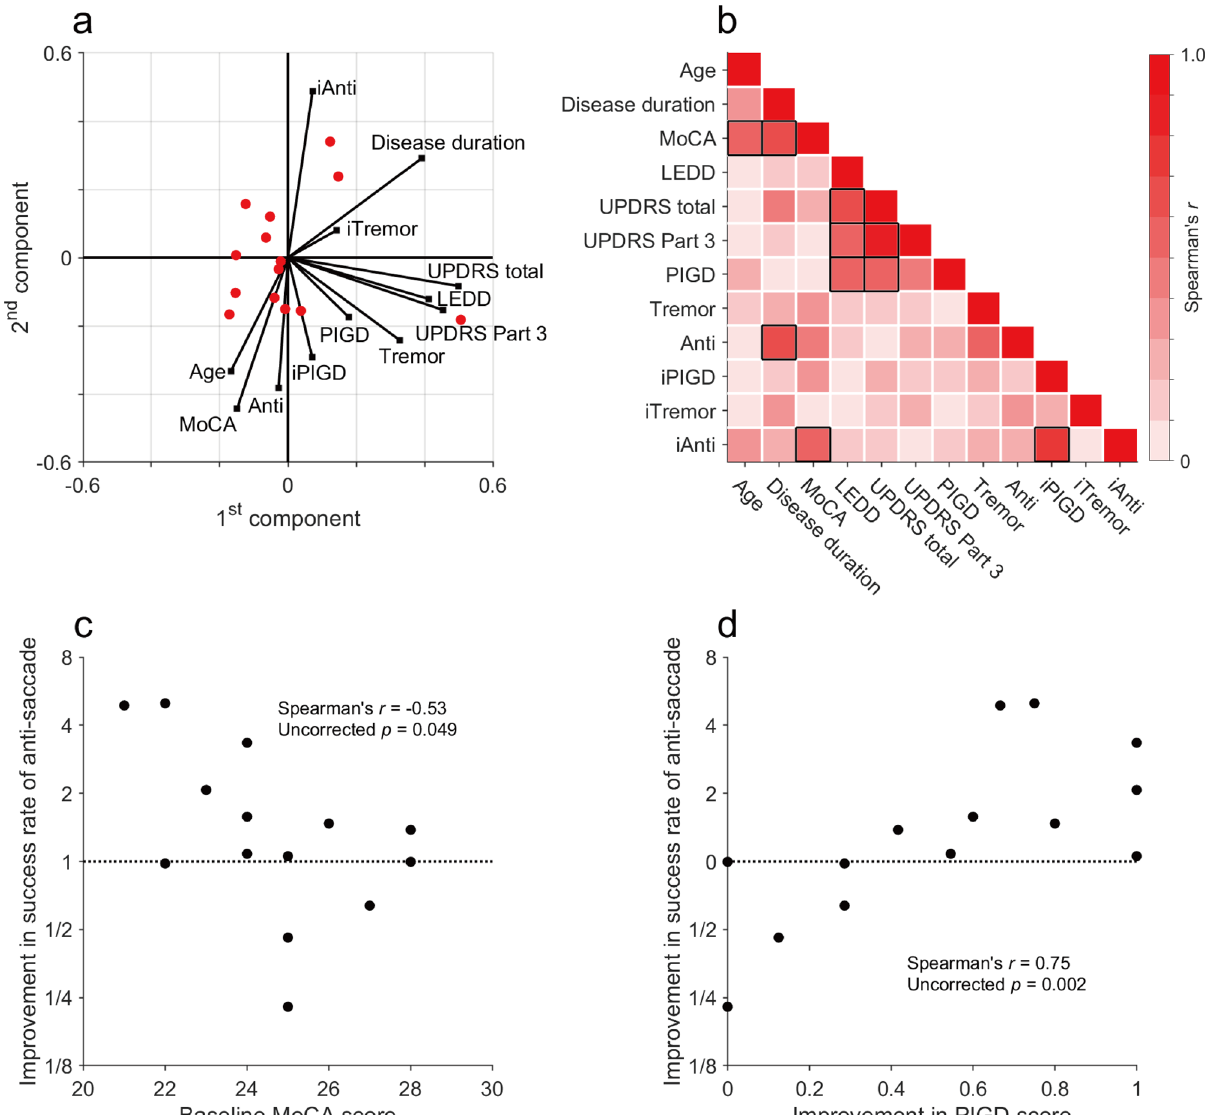
Figure 2. Relationships among the rTMS effects on the anti-saccade success rates, MDS-UPDRS scores, and the patients’ demographic and clinical characteristics. ( a ) We conducted PCA of the demographics as well as baseline and post-rTMS improvement in motor symptoms and saccade performance. The two main components are represented. Red dots and black lines indicate the distribution of the patients and variables, respectively. PIGD, Tremor, and Anti represent the baseline PIGD score, tremor score, and anti-saccade success rate, respectively. iPIGD, iTremor, and iAnti represent the improvement in PIGD score, tremor score, and anti-saccade success rate, respectively. ( b ) Heat maps of absolute values of Spearman’s correlations between the variables plotted in a . Weak correlations are in white, while strong correlations are in red. The variables surrounded by black lines indicated uncorrected p < 0.05. ( c ) Correlations of improvement in the anti-saccade success rate with baseline MoCA-J scores and ( d ) improvement in PIGD scores are